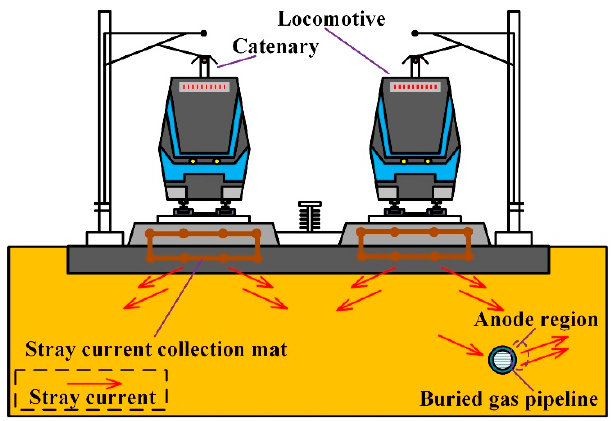
Figure 1. Stray current in the light rail system.